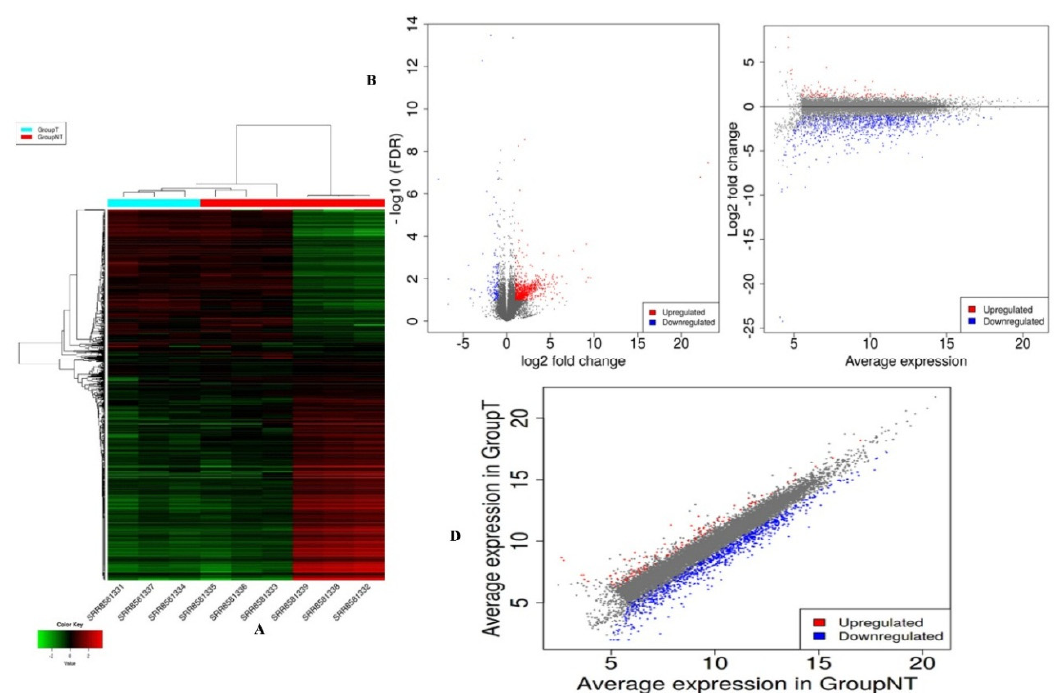
Figure 3. Heatmap and plots of differentially expressed genes in comparison-II ( A ) heatmap build with top 1000 differentially expressed genes, ( B ) volcano plots with DEGs, ( C ) MA plot with DEGs and ( D ) scattered plots with